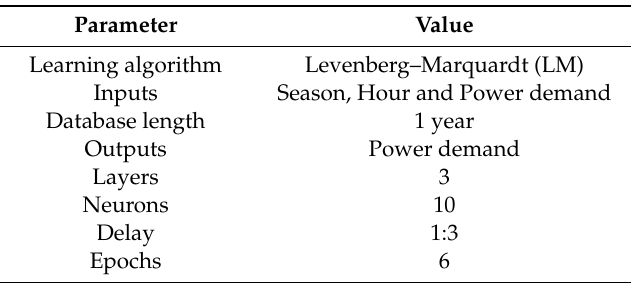
Table 12. Key parameters of the developed